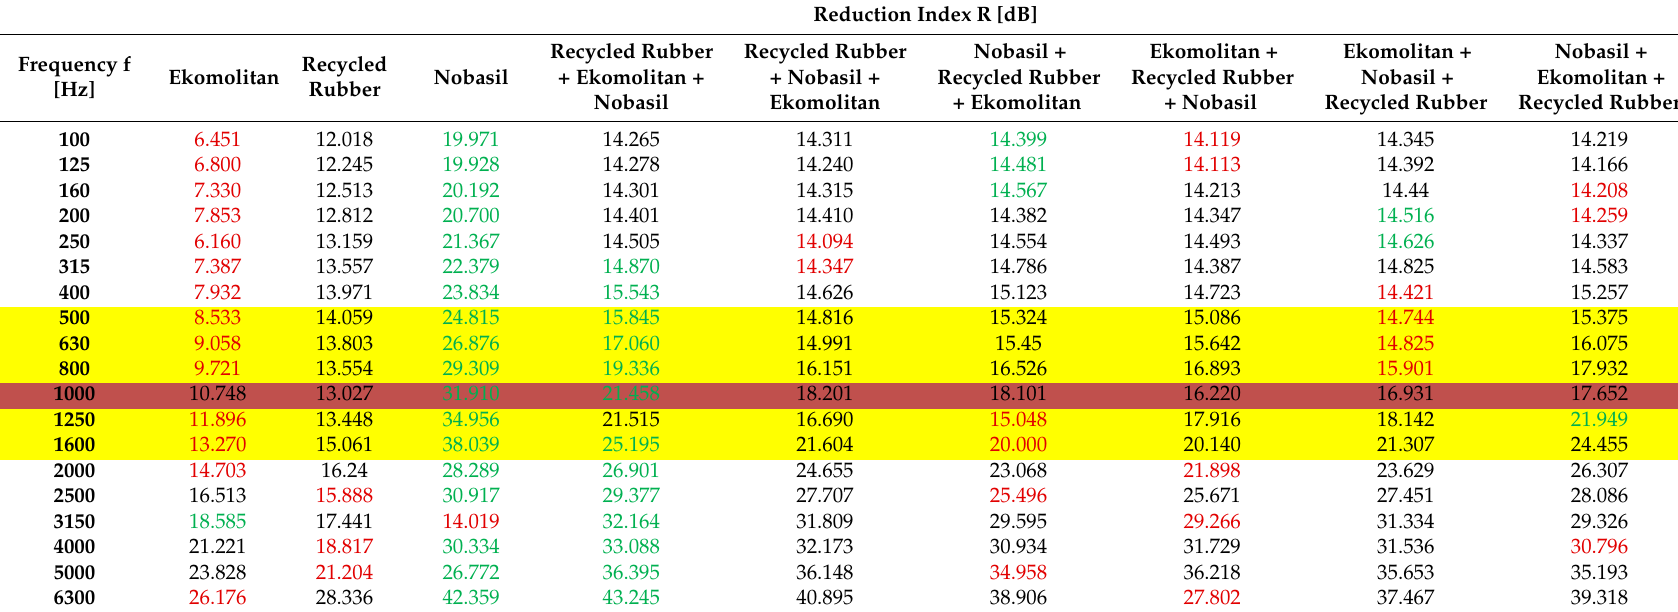
Table 2. Reduction index R values for materials with thickness of 60